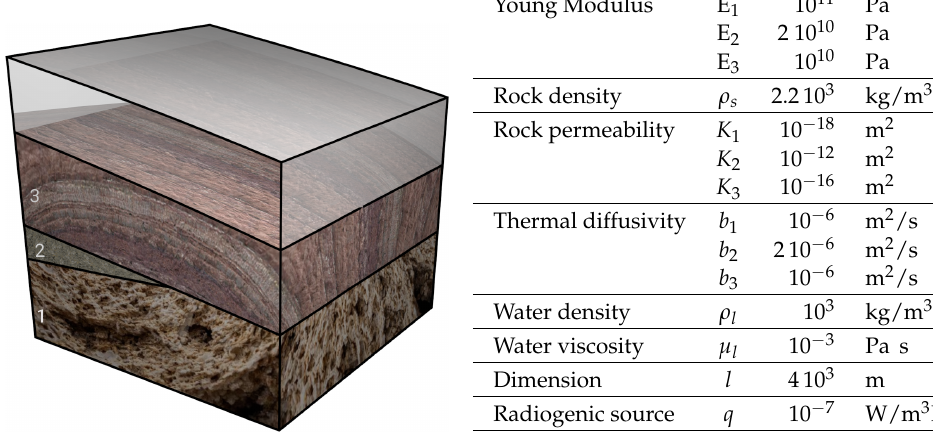
Figure 7. On the left we show a sketch of the physical domain, ot top of which is superposed a layer visualizing the ice sheet. The labels 1,2,3 mark the different materials. On the right the list of materials properties is